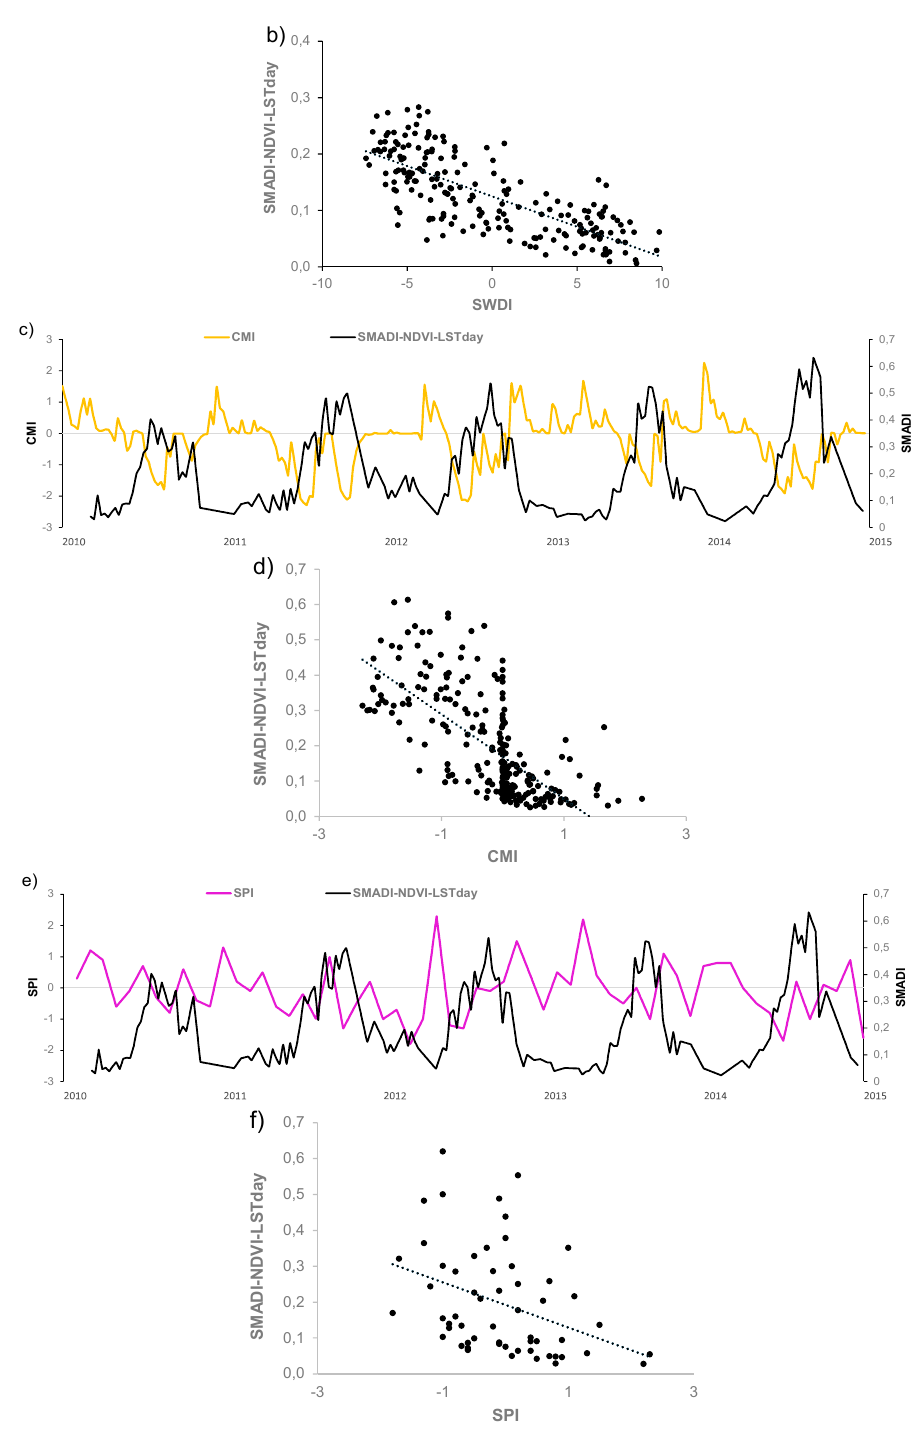
Figure 4. ( a – f ) Comparative evolution between SMADI (NDVI and LST day version) and the SWDI at the REMEDHUS area average ( a ); the CMI at the Matacán station ( c ) and the SPI at the Matacán station ( e ). Scatter plot of series correspond to ( b,d,f ), respectively. Since the SSM itself, the LST or the water/vegetation indices could also be potential indicators of drought, they were also compared to the SWDI over REMEDHUS (Table 2). High correlations were